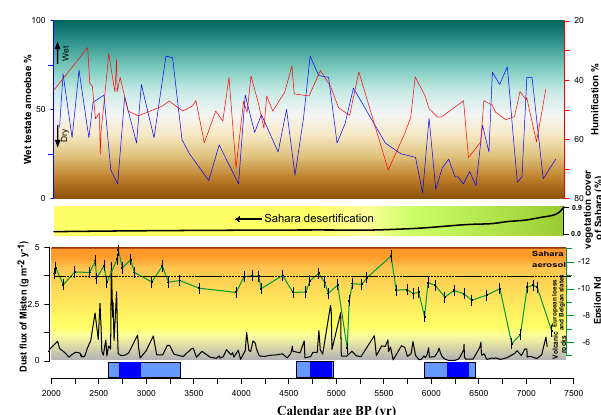
Fig. 9. Comparison of the Misten proxies (dust flux, ε Nd, humifi- cation and testate amoebae). The testate amoebae were classified according to their affinity with wet conditions. The three dark- blue bars show the cold events according to Wanner et al. (2011) and the three light-blue bars show the uncertainty in the length of cold events. The Saharan desertification model is from Claussen et al.